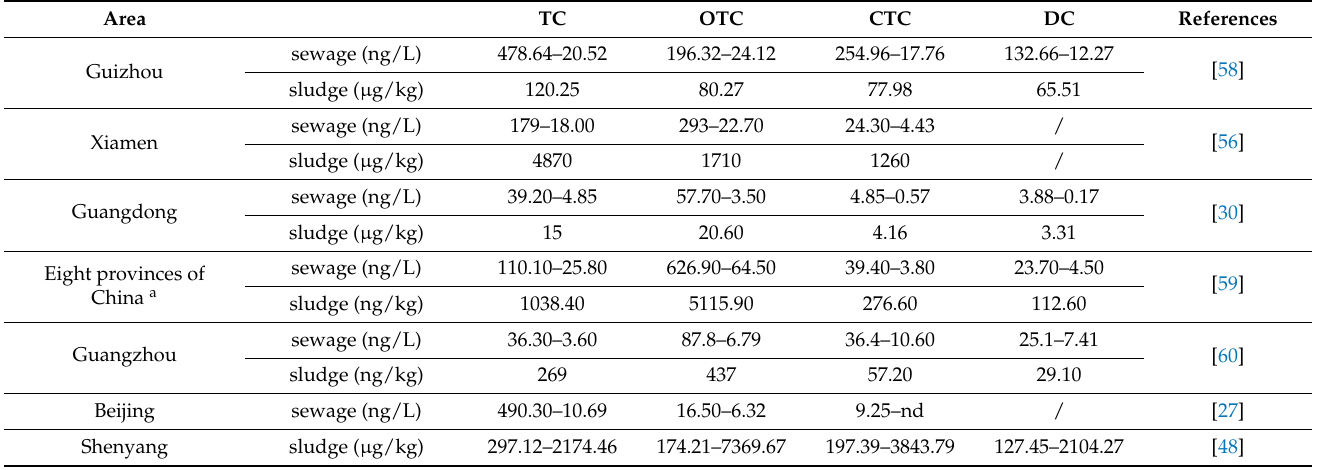
Table 2. Residual content of TCs in